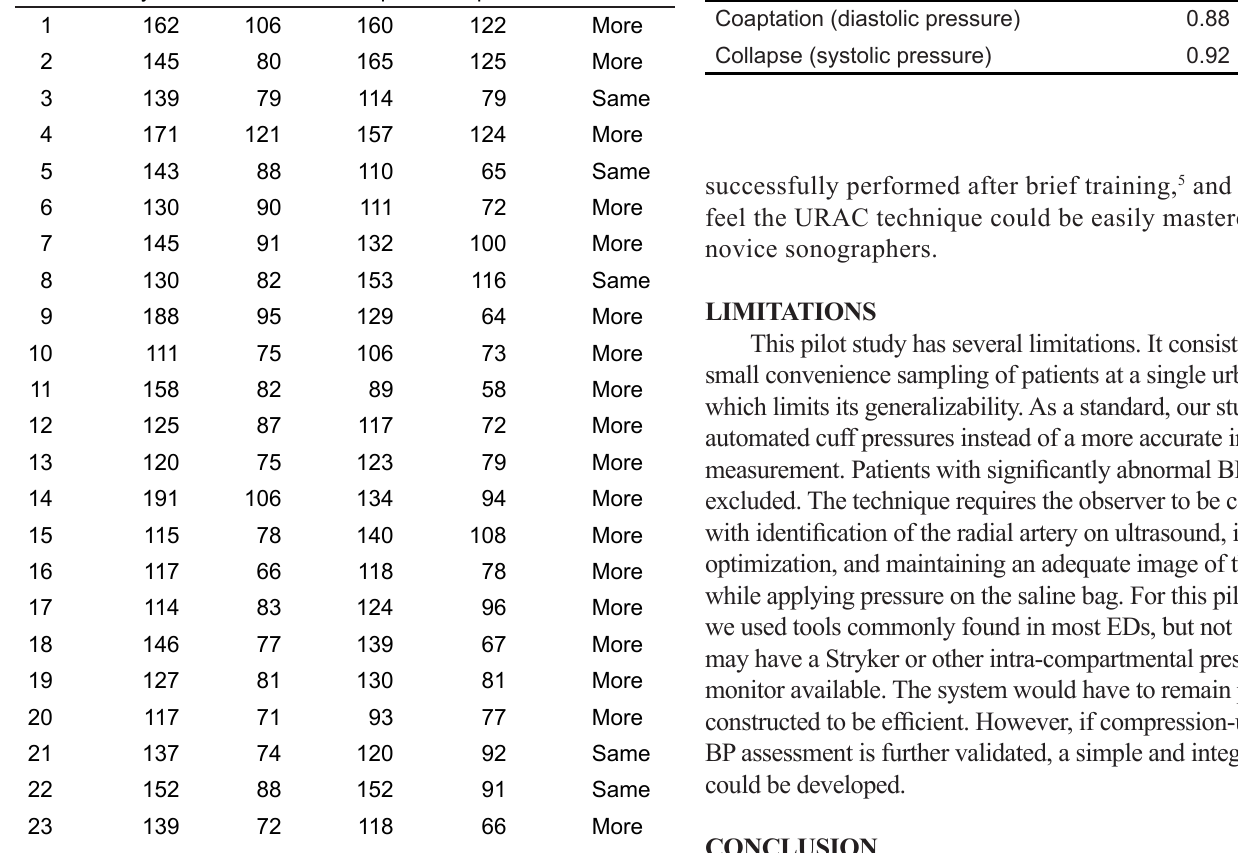
Table 3. Automated cuff BP compared to ultrasound-guided radial compression (URAC) BP and comfort level.